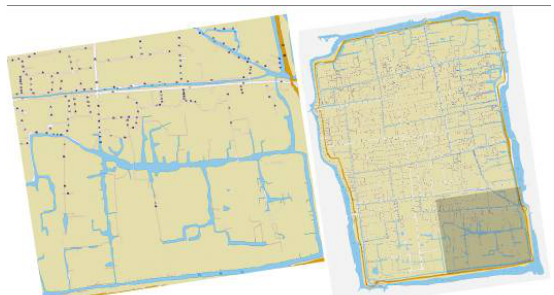
Figure 10 ． Same part from the map of 1930’s. Showing waterways in irregular shapes, widths and directions.